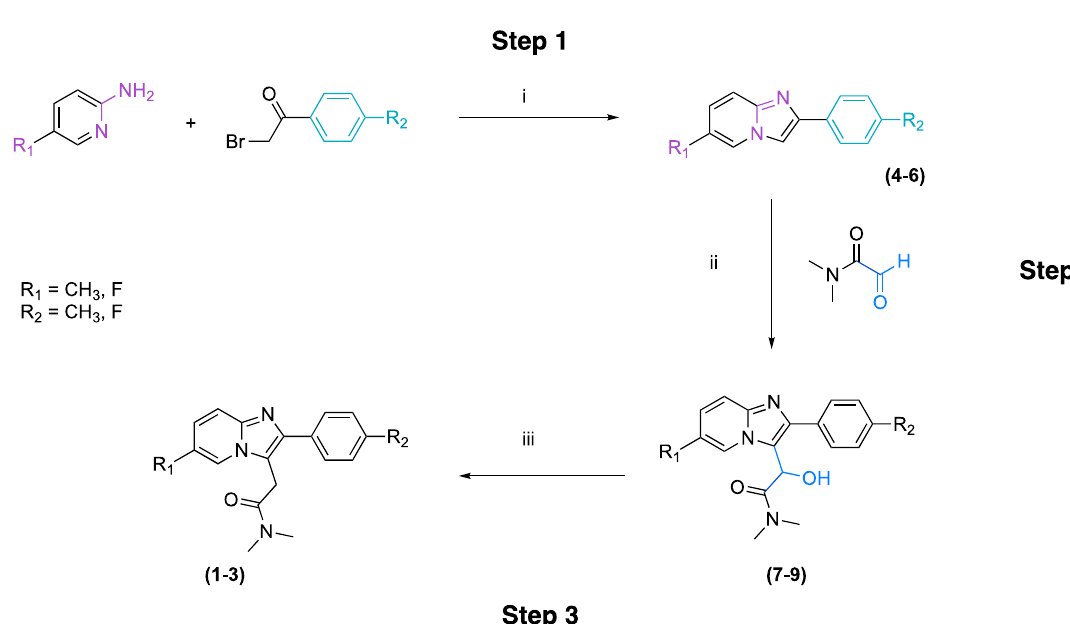
Scheme 1. Schematic representation of the protocol developed under microwave irradiation.